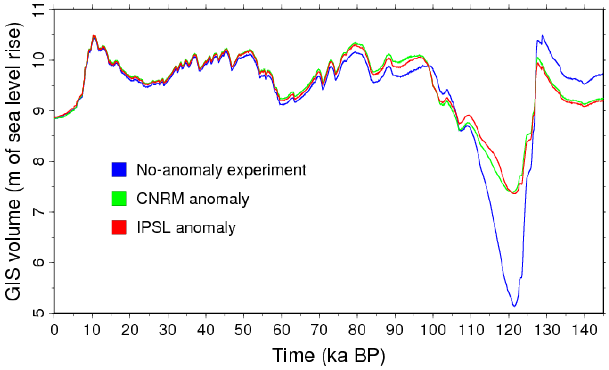
Fig. 6. Simulated Greenland ice volume, expressed in m of sea level equivalent. For the 0–100 ka BP the atmospheric forcings are the same in the three experiments, resulting in a very similar volume evolution.